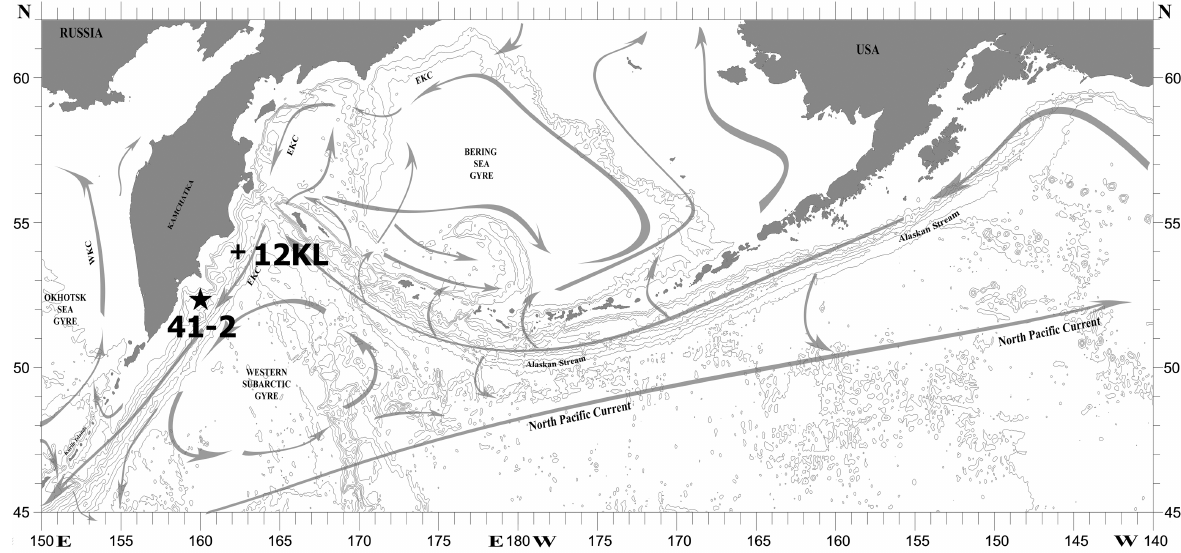
Figure 1. Bathymetry, surface water currents and location of the cores 41-2 (star) and 12KL (cross) (Max et al., 2012) in the N Pacific. Surface currents as in Favorite et al. (1976) with modifications. EKC – East Kamchatka Current; WKC – West Kamchatka